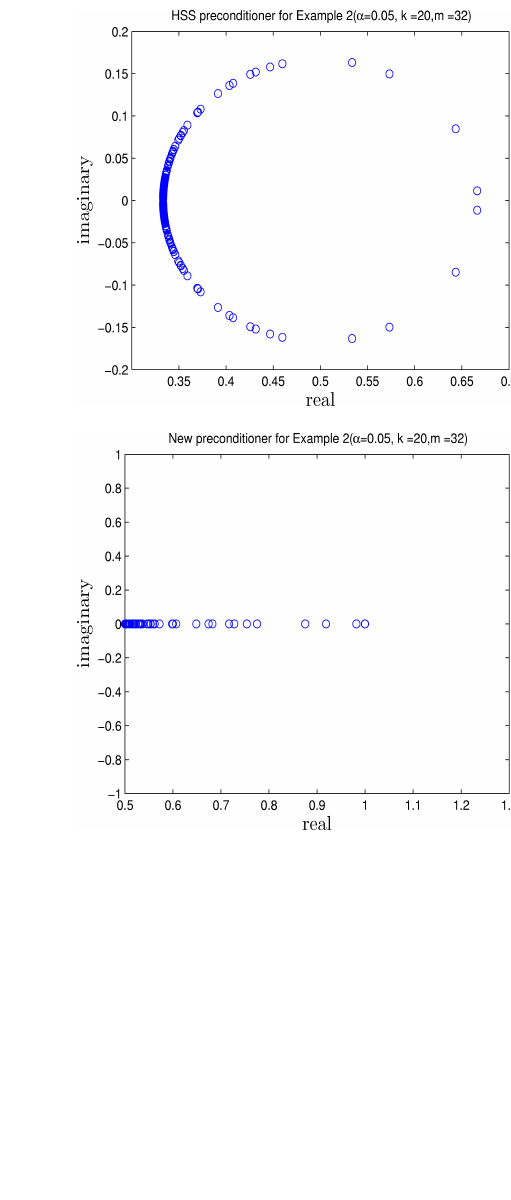
A , P − 1 A and P − 1 A for 2 HSS PSHNS